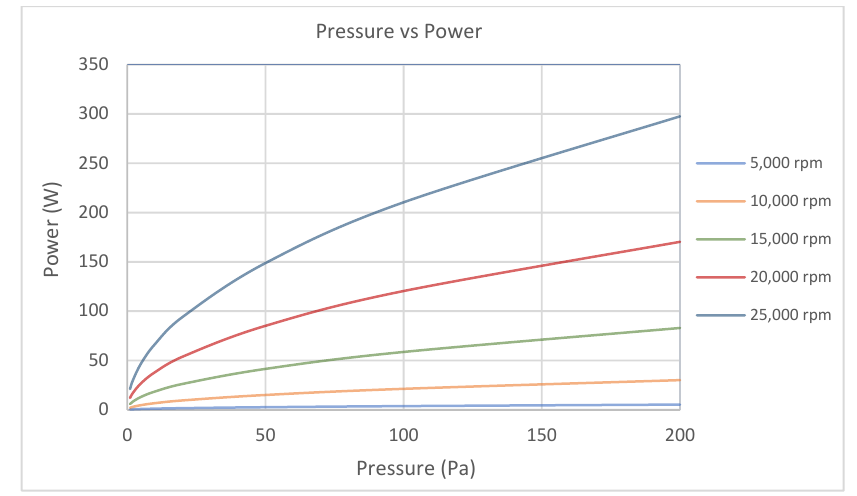
Figure 10. Effect of pressure on windage loss under constant angular velocities.